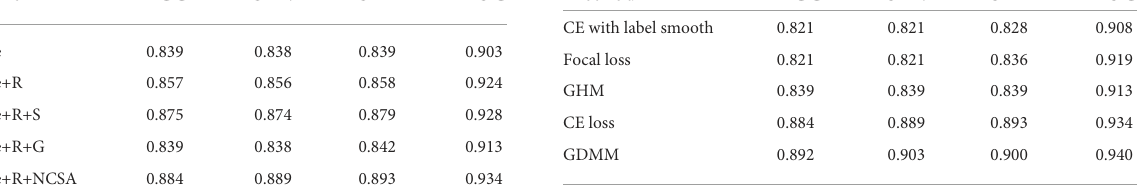
TABLE 7 Quantitative evaluation of ablation analysis for different attention structures in the ADNI dataset. Structure